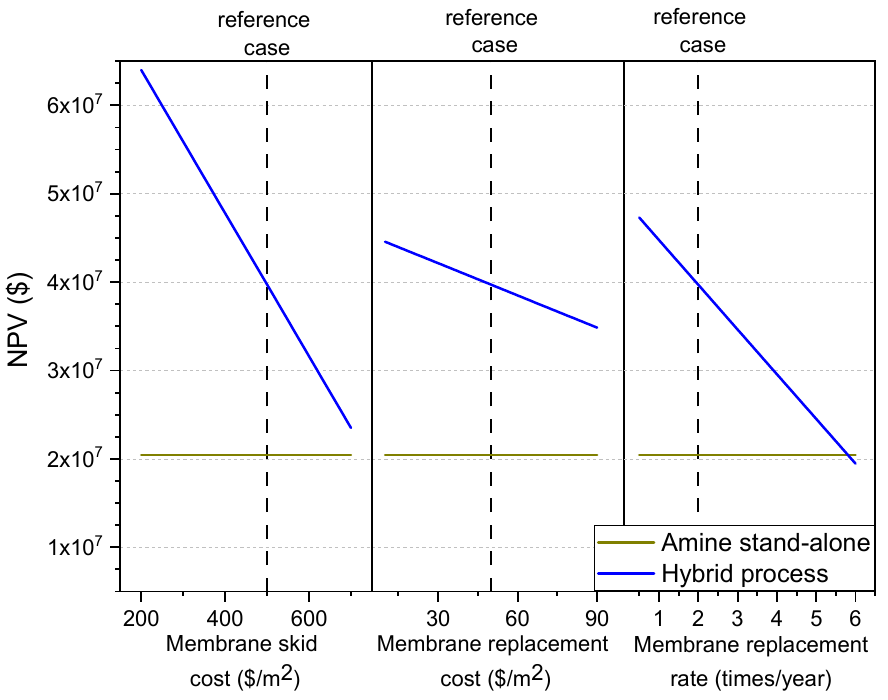
Figure 11. Effect of the membrane skid cost (left part), the membrane material cost (middle part), and the membrane replacement rate (right part) on the NPV value. The amine stand-alone process NPV is shown for comparison (dark yellow line).